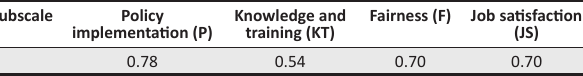
TABLE 1: Cronbach’s alpha coefficients for subscales. Subscale Policy Knowledge and implementation (P) training (KT)